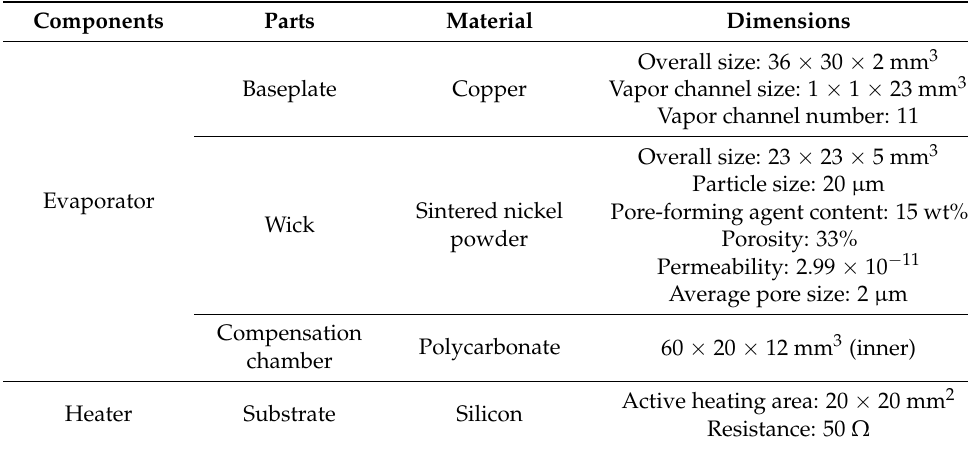
Figure 2. Three-dimensional diagram of the evaporator: ( a ) front view of cross-section drawn; ( b ) side view of cross-section drawn. Table 2. Main dimensions and test conditions in the